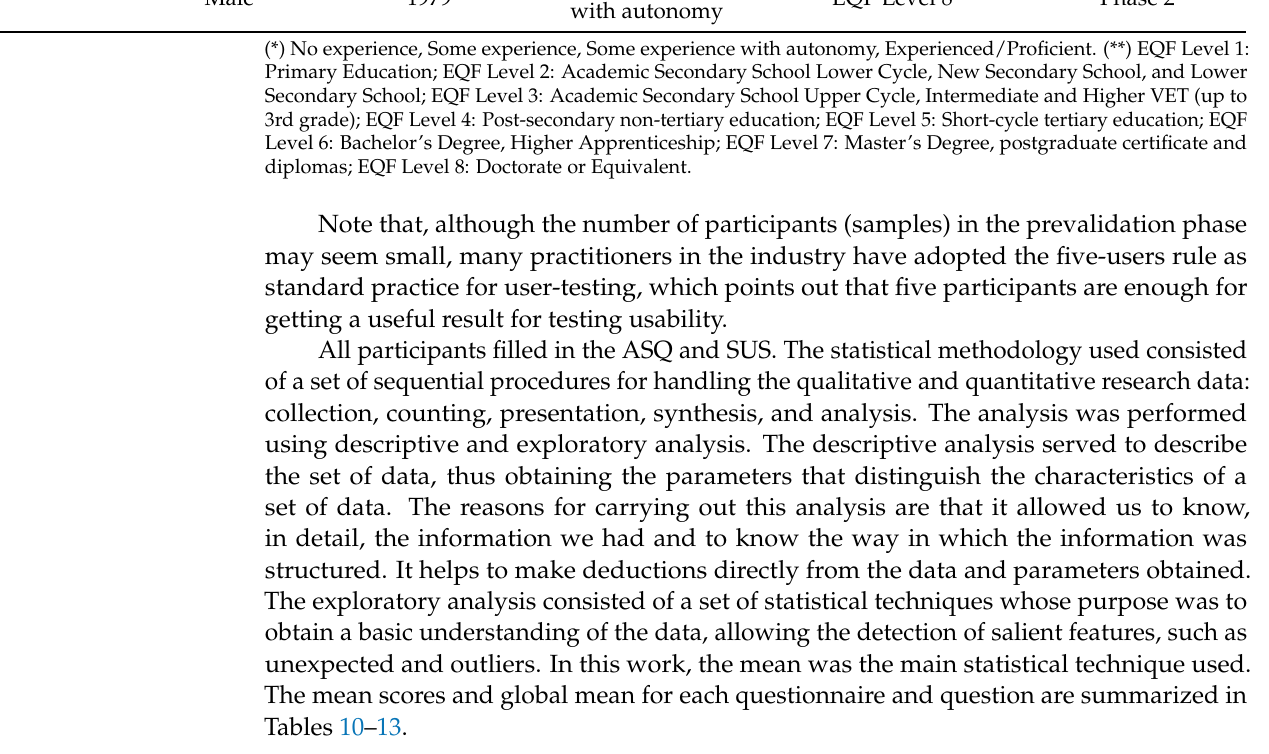
Table 10. ASQ mean scores for the individual technologies during the pre-validation phase